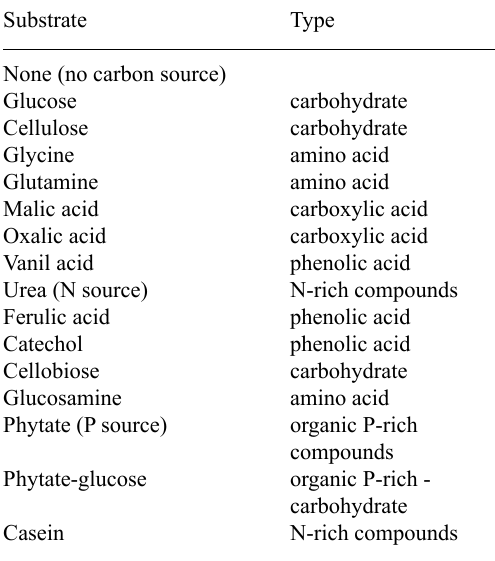
Table 1. Substrate used for MicroResp-CLPP analysis Substrate Type